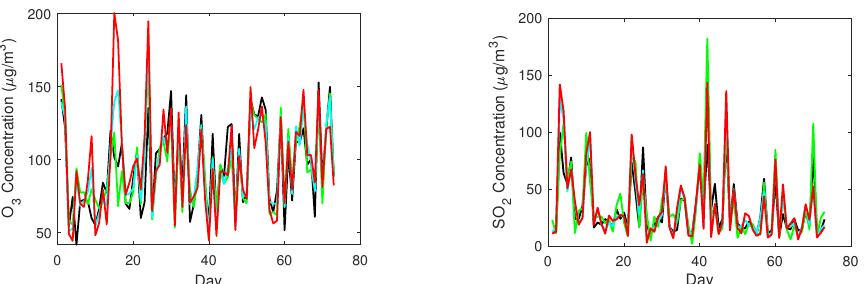
Figure 8. The observed concentrations and the predicted concentrations of DTR, FFANN-BP and RFR for O 3 and SO 2 at Ma Lian Kou, where the red line and the black, green and lightcyan lines represent the observations, and the predictions of DTR, FFANN-BP and RFR, respectively.